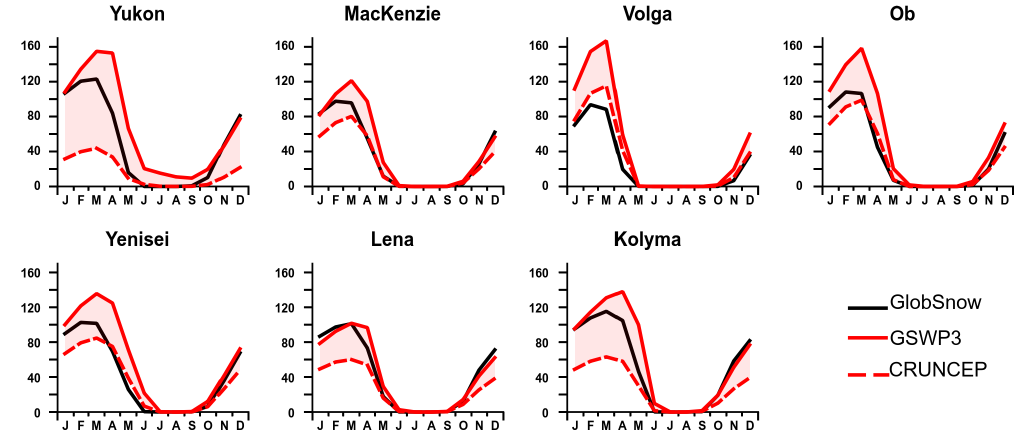
Figure 9. Monthly mean seasonal SWE (mm) simulated with the two forcings compared to GlobSnow over the seven basins (see Fig. 2b), averaged over the period 1981–2007.